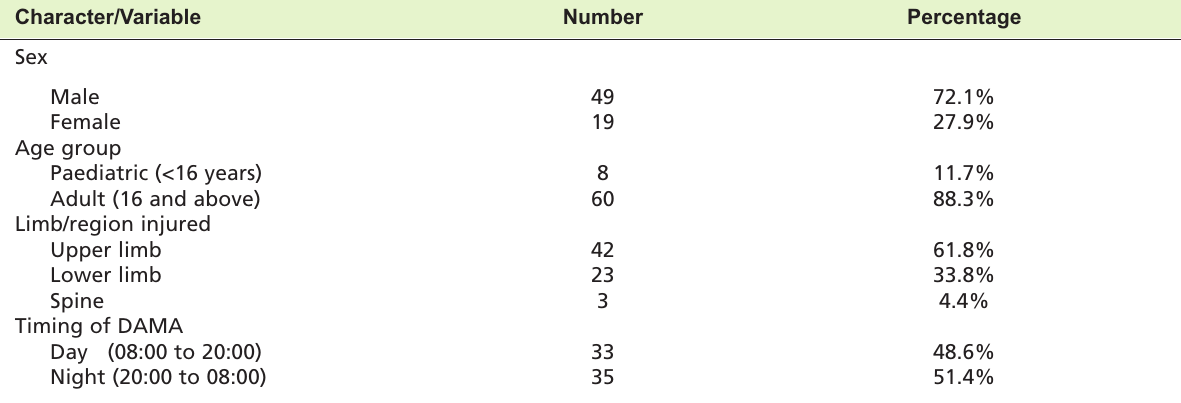
Demographic characteristics of Orthopaedic patients going discharge against medical advise Table I: